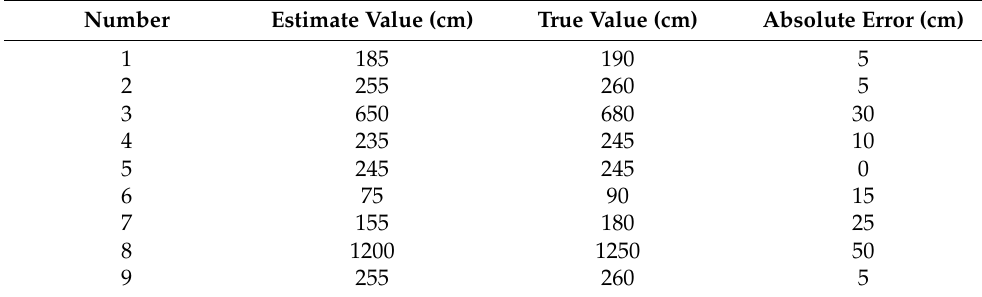
Figure 33. Mapping results of second environment, number 1–9 mean the length of each side. Table 14. Mapping errors of second